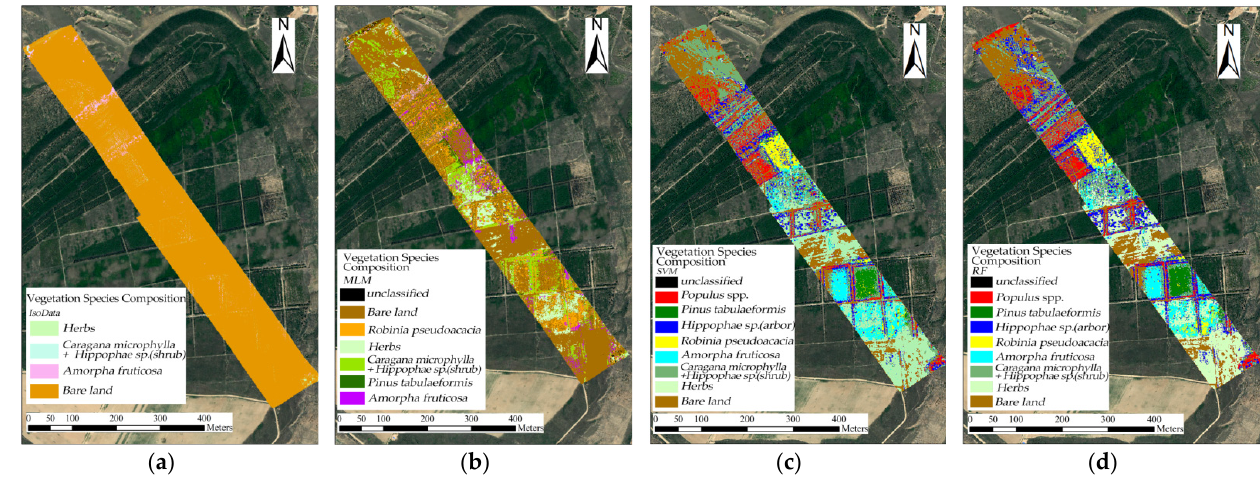
Figure 18. The results of vegetation species composition types using different classification methods: ( a ) IsoData unsupervised classification; ( b ) maximum likelihood supervised classification; ( c ) support vector machine classification; ( d ) direct random forest classification. Table 6. Accuracy of the classification of vegetation species compositions.